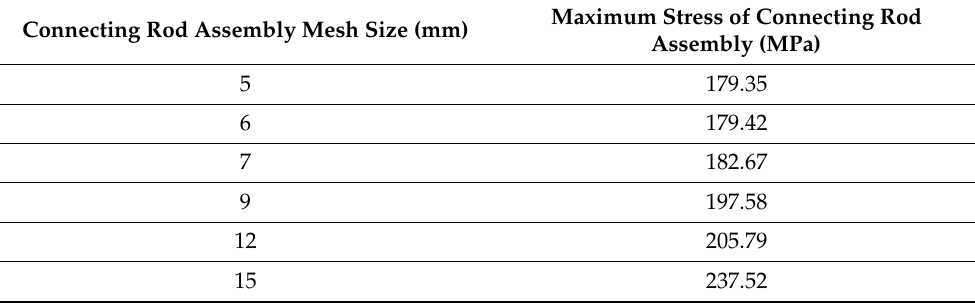
Table 2. Grid independence analysis in simulation calculation of connecting rod assembly.